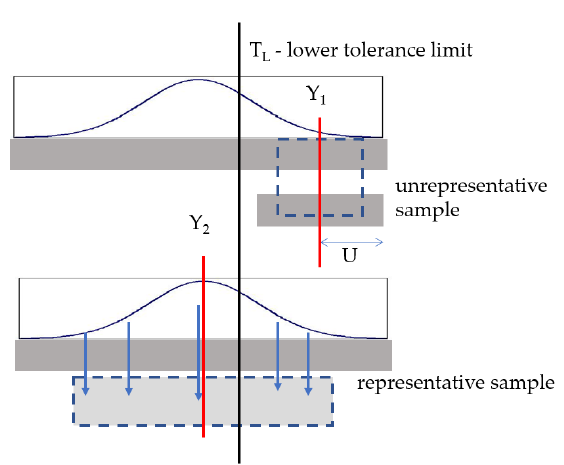
Figure 3. Illustrative diagram showing a non-representative sample ’ s impact on the population assessment. Y 1 — non-representative sample ’ s test result, U — uncertainty estimated by the laboratory. Y 1 > T L and Y 1 − U > T L means the product will be classified as compliant regardless of whether the simple or guarded acceptance rule is applied. Y 2 — actual result applying to the whole population. Most of the population does not comply with the requirement.